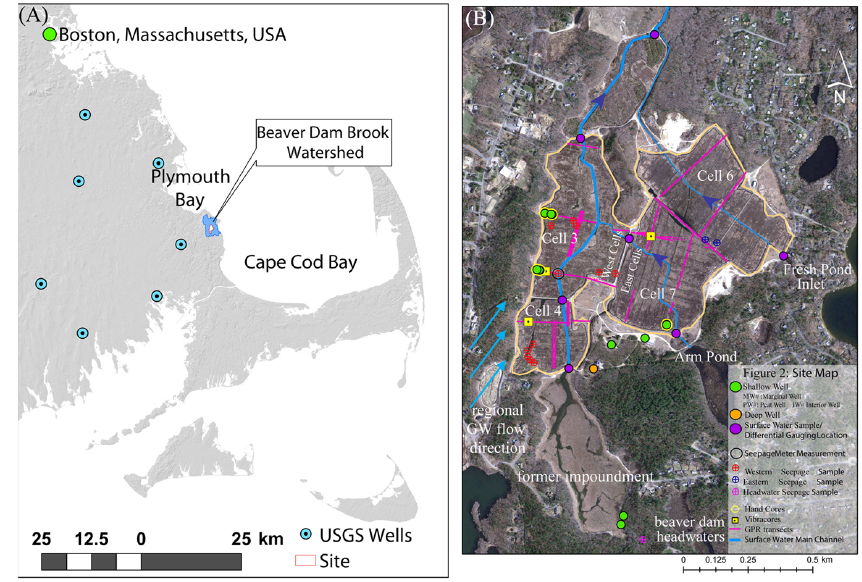
Figure 1. (a) Site map of the Tidmarsh Farms regional peatland showing the study area and watershed boundary; Plymouth County, Mas- sachusetts, and PCKD USGS wells used for regional groundwater isotopic data (Table 1). (b) Detail of the Tidmarsh Farms study site showing the major waterways and flow direction in blue, site groundwater wells, isotopic sample locations, and GPR transects. Beaver Dam Brook flows north into Plymouth